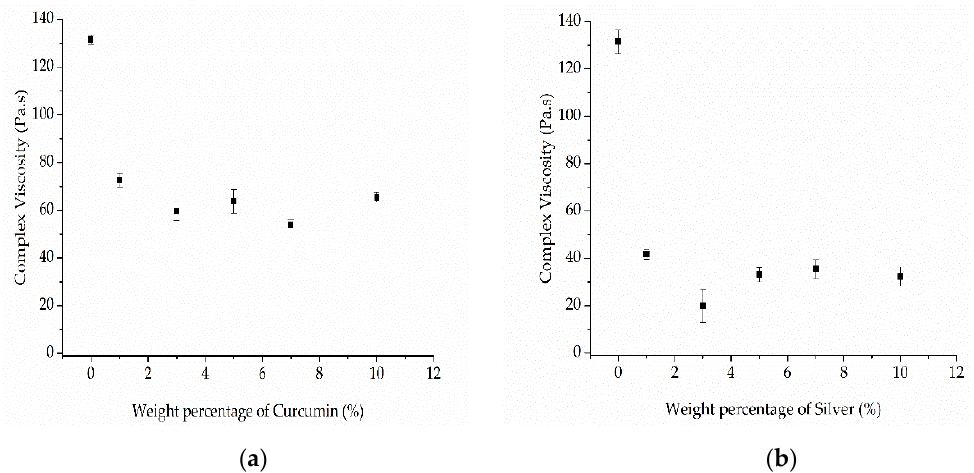
Figure 12. Rheogram showing the complex viscosity of ( a ) PBS-curcumin compounds and ( b ) PBS- silver compounds as a function of temperature at an angular frequency of 10 rad/s. Data are means ± standard deviations ( n = 3).